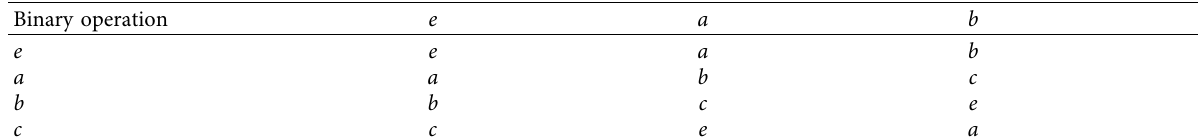
Figure 4: A commutative diagram. Table 1: A digital multiplication m